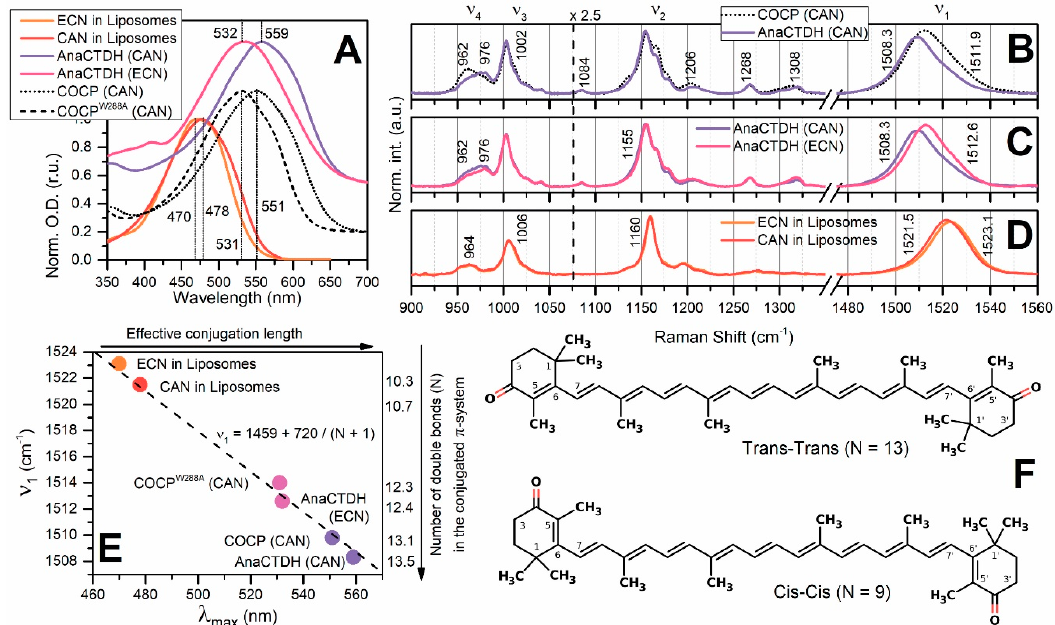
Figure A1. Spectral properties of ECN and CAN in different environments. ( A ) Normalized absorption of AnaCTDH containing CAN (violet) and ECN (purple). Orange and red lines show the absorption of ECN and CAN in liposomes, respectively. Dotted and dashed lines show the absorption of COCP and the W288A sequence variant thereof, respectively, both containing CAN. Spectra were shifted along the y -axis for the better presentation. ( B , C ) Resonance Raman spectra of CTD-like carotenoid proteins recorded with 532 nm excitation. ( B ) AnaCTDH (solid violet line) and COCP (dotted line), both containing CAN. ( C ) AnaCTDH containing CAN (violet) and ECN (purple). ( D ) Raman spectra of ECN in liposomes. The Raman signal in the 900–1060 cm − 1 region was magnified 2.5 times for better presentation. Note the x -axis break from 1350 to 1475 cm − 1 . ( E ) Dependency of the Raman shift of the -C=C- stretching mode ( ν 1 ) on the position of the S 0 –S 2 maximum ( λ max ) in absorption spectra of ECN and CAN embedded in liposomes and proteins. Arrows indicate, how the effective conjugation length and the average number of double bonds changes among samples. The average number of conjugated double bonds was calculated using the empirical dependency denoted in the text [48]. ( F ) Chemical structures of cis-cis and trans-trans isomers of CAN.